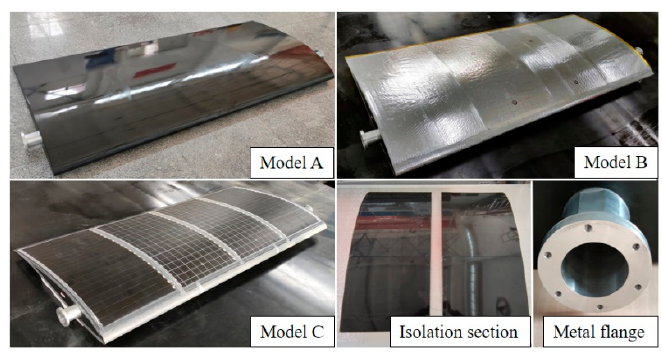
Figure 2. Three kinds of experimental models. Table 2. The equivalent mechanical properties of the membranes.